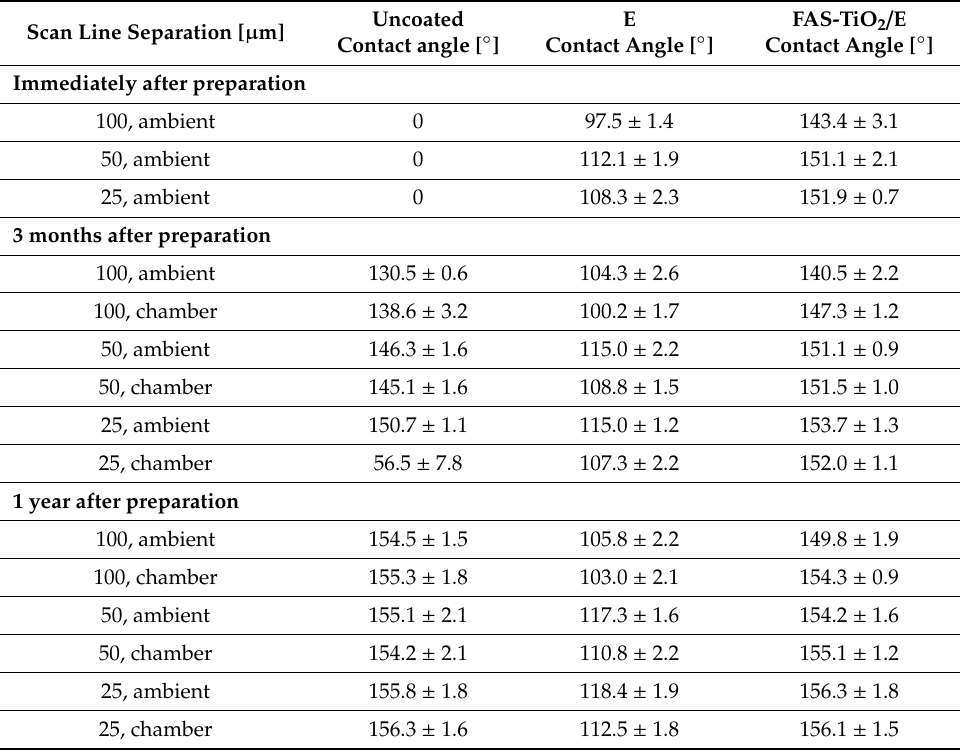
Table 3. Comparison of static water contact angles of uncoated, epoxy-, and FAS-TiO 2 / E-coated